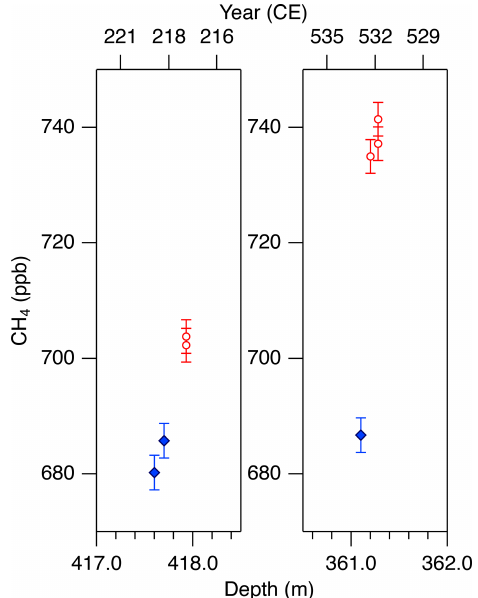
Figure 11. Detailed views of individual CH 4 data for the abrupt (non-atmospheric) increases in the NEEM core at ∼ 418 and 361m. Data shown in blue agree with the GISP2 data, and those in red are unrealistically high (interpreted as natural